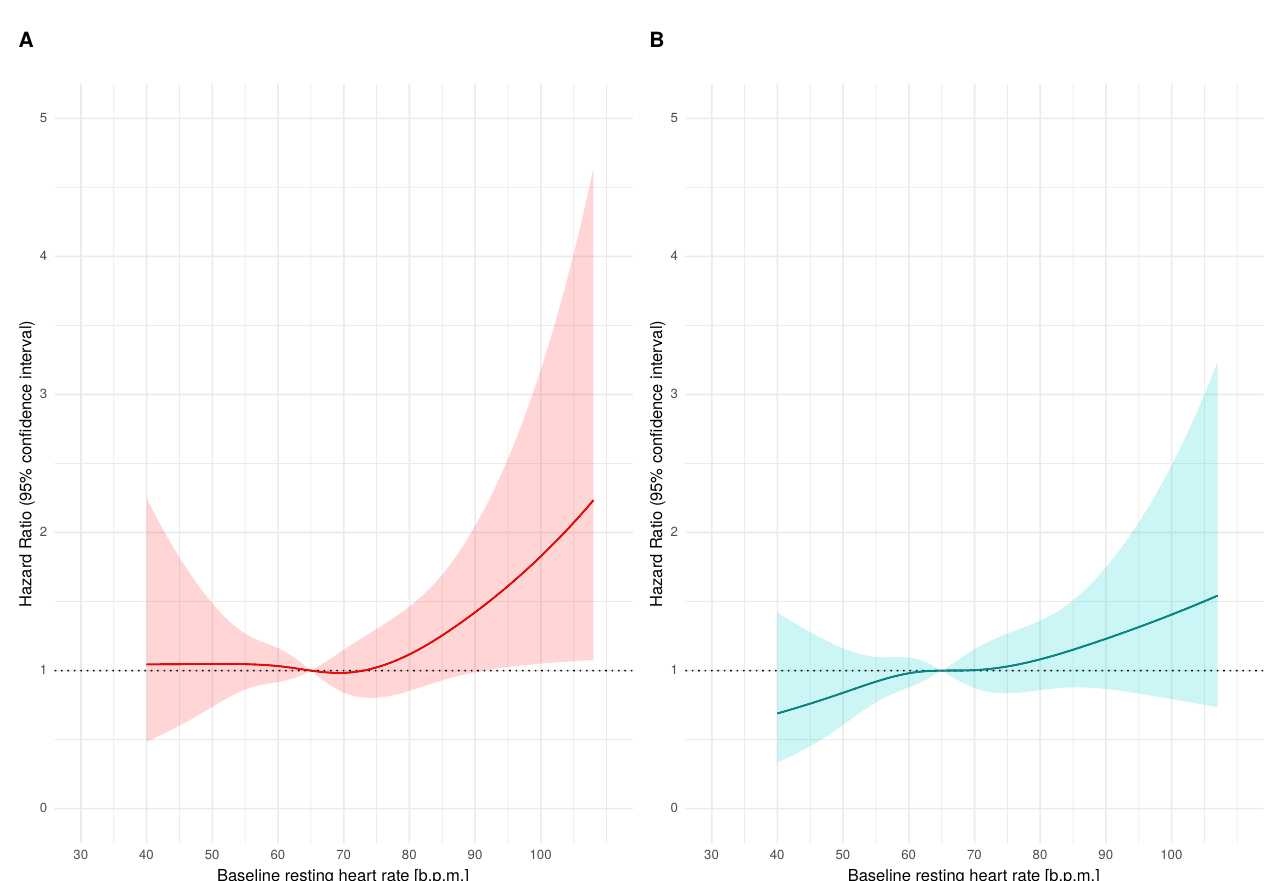
100 Baseline resting heart rate [b.p.m.] Figure 2. Hazard ratio with 95% confidence intervals against baseline resting heart rate in intensive (panel ( A ), red) and standard (panel ( B ), blue) treatment